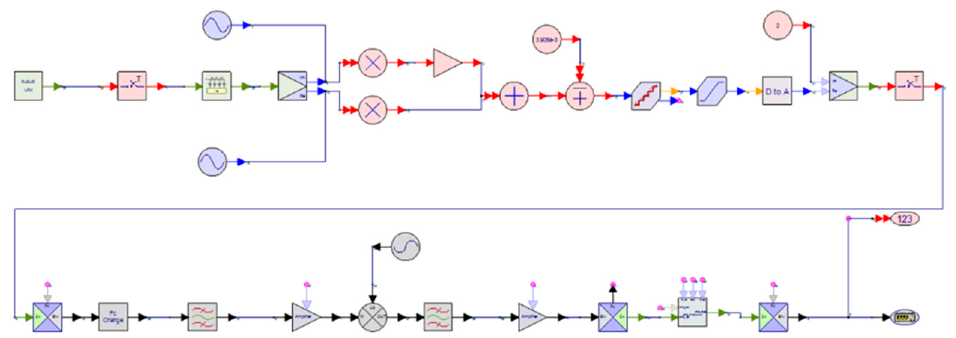
Figure 4. Radar system modeling.